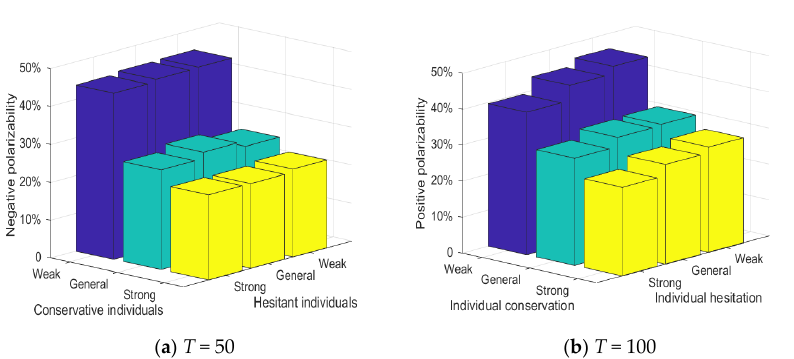
Figure 19. Relationship between three conservative individuals, hesitant individuals and attitude polarization. ( a ) T = 50; ( b ) T = 100.